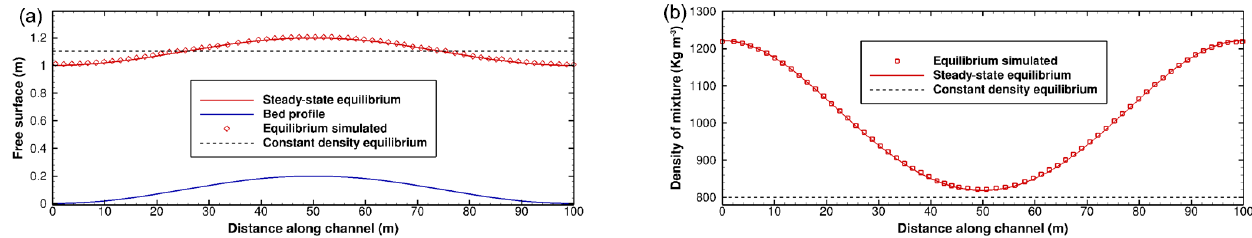
Figure B2. Quiescent equilibrium test. Comparison between theoretical and numerical profiles of hydrodynamic variables. (a) Free surface and (b) fluid density.